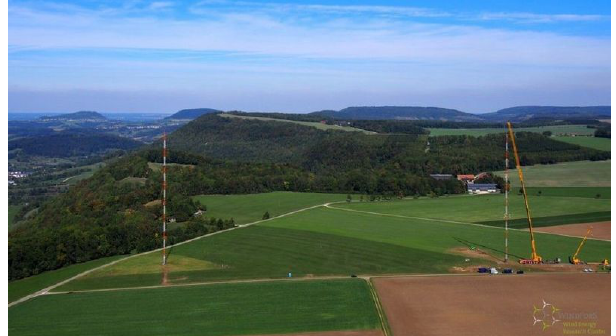
Figure 1. WindForS test field in Stöttener Berg (from Testfield, 2017) with focus on the two met